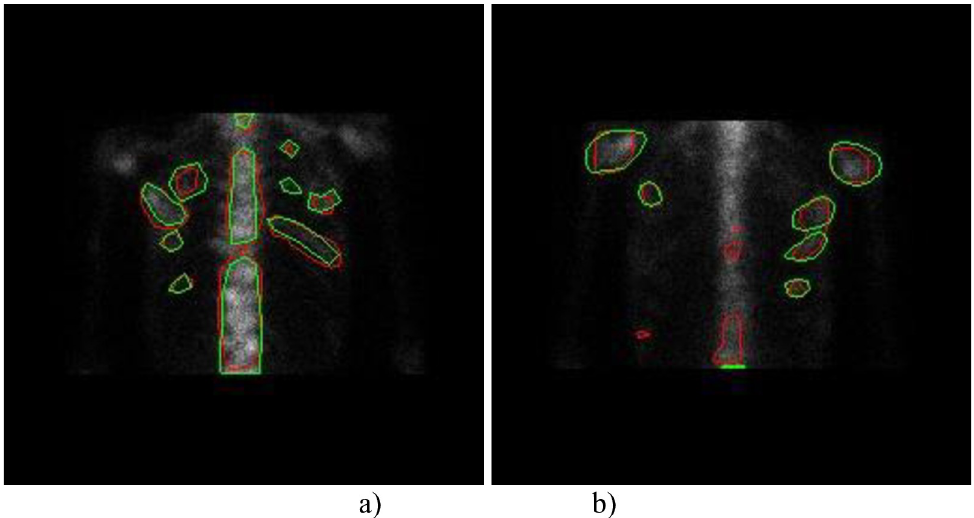
Fig 13. A visualization of hotspots segmented by U-Net-Res model for two thorax bone SPECT images (the model segmented results marked with green and the manually labeled ones marked with red). a) The best case; and b) The worst